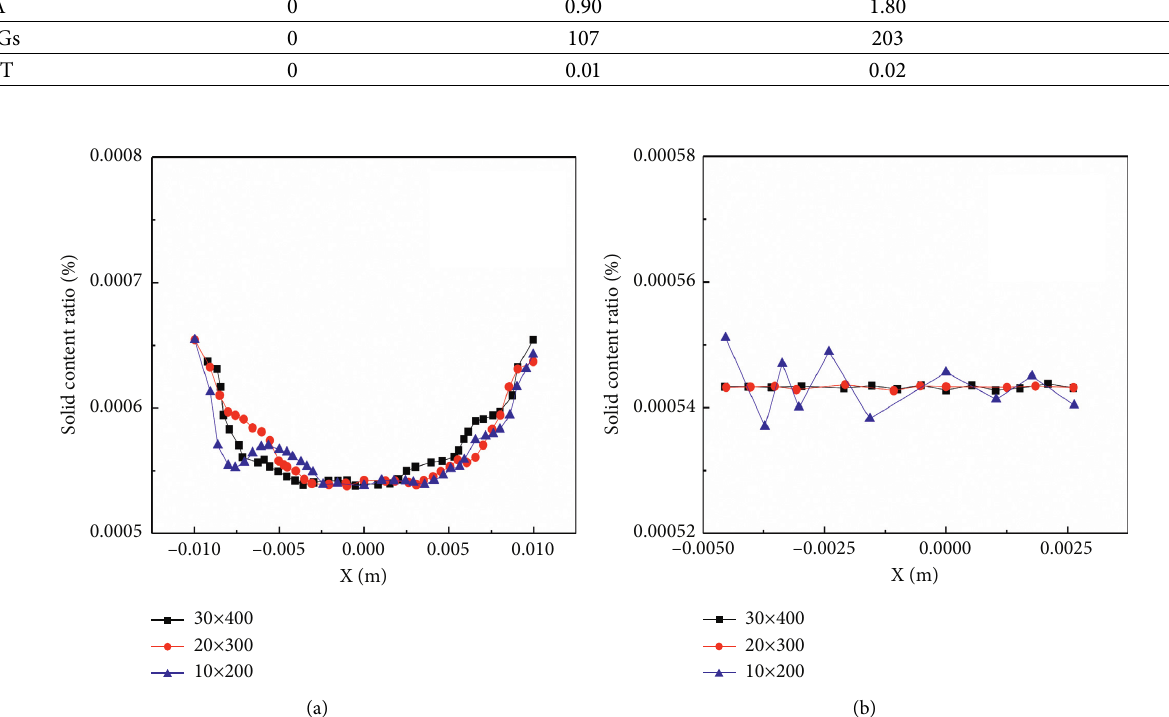
Figure 3: Effect of grid scaleon nanomagnetic enzymedistribution. (a)Distribution of solidcontent of nanomagnetic enzyme particlesat different mesh scales of MFB whole. (b) Distribution of solid content of nanomagnetic enzyme particles at different mesh scales of MFB local.